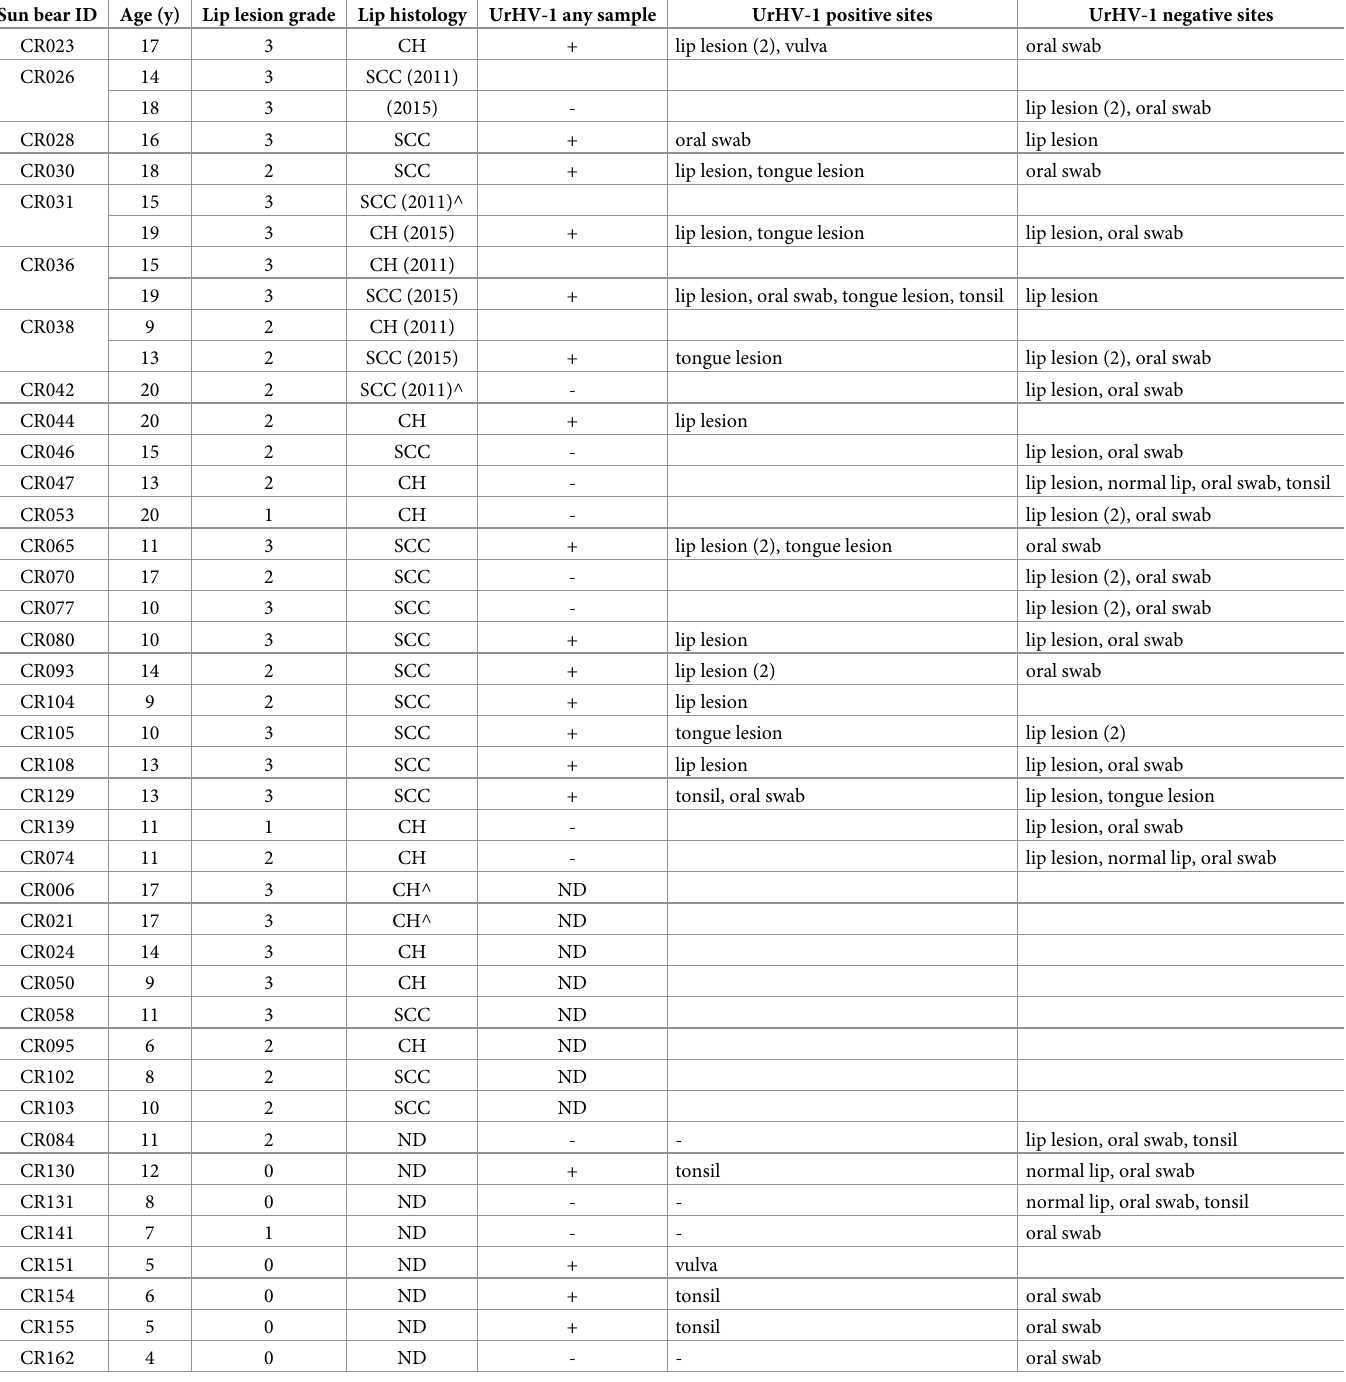
Table 2. Combined available results of lip histology and Ursid gammaherpesvirus 1 PCR for 39 sun bears ( Helarctos malayanus ) at a Cambodian rescue centre from 2011–2016. Sun bear ID Age (y) Lip lesion grade Lip histology UrHV-1 any